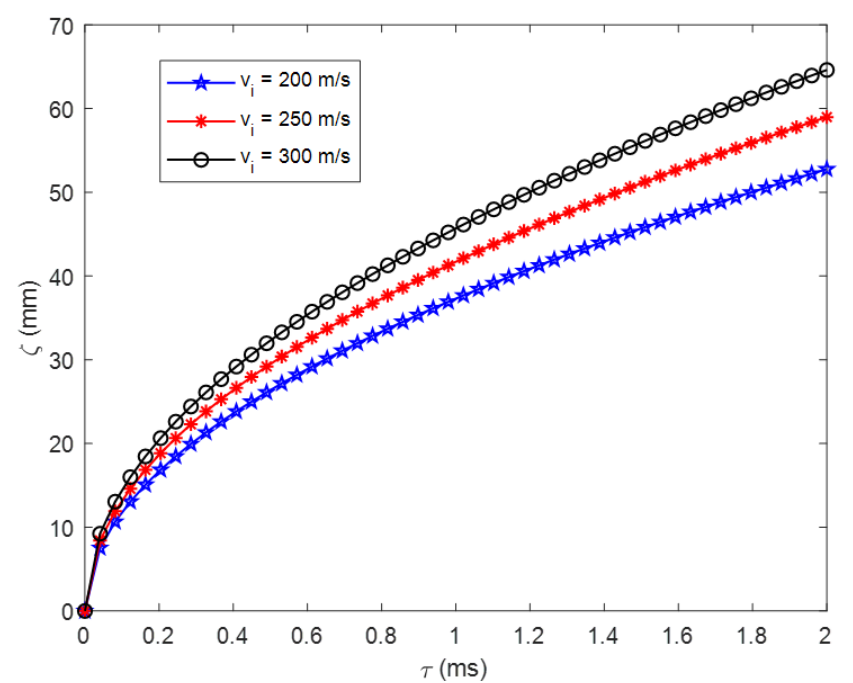
Figure 3. Effect of droplet initial